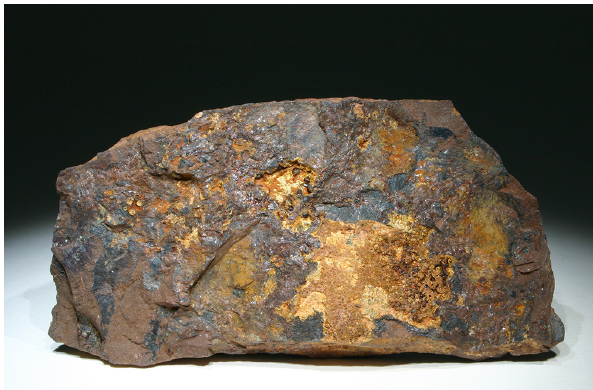
Figure 1. Original specimen of beraunite, in paragenesis with cacoxenite and wavellite. Hrbek mine, Svatá Dobrotivá (St. Be- nigna), Beroun, Bohemia, Czech Republic. Mineralogical Collec- tion of the TU Bergakademie Freiberg, inv. no. 21519 (sample FR). 10.5 × 5cm. Photo A.